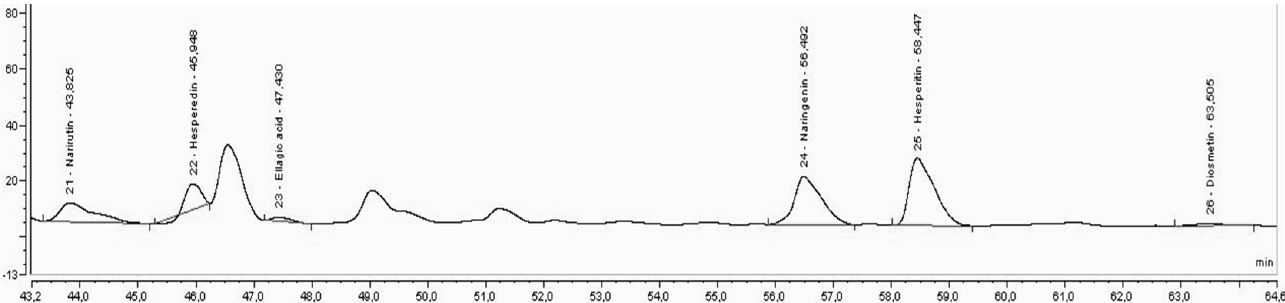
Figure 5. Chromatography of the extraction performed with DES3 in two steps.